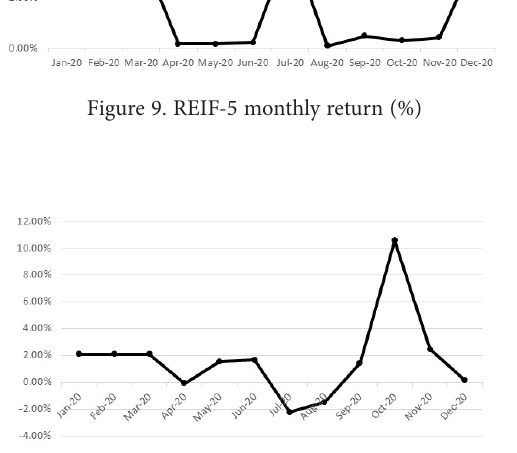
Figure 10. REIF-6 monthly return